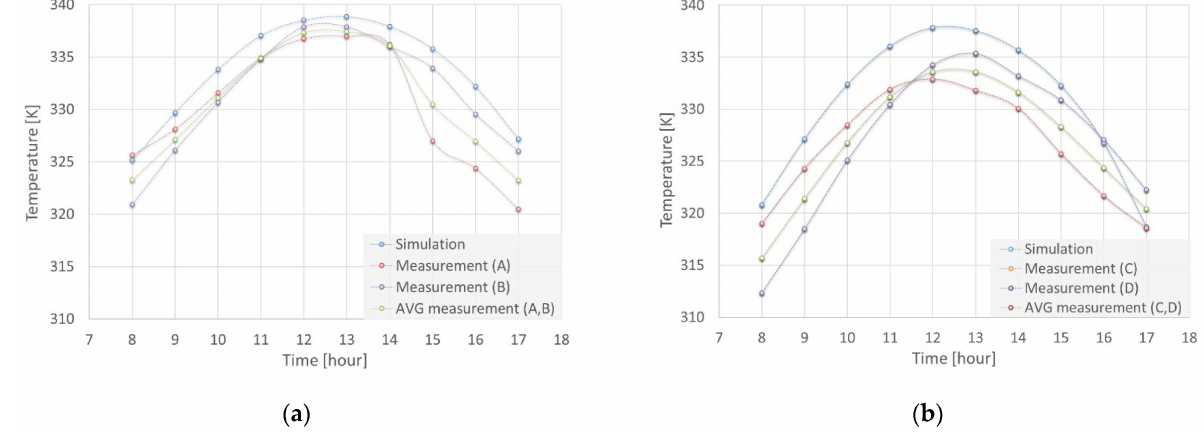
Figure 21. Comparison of the outlet temperature of solar collectors from measurement and simulation for ( a ) rotation collectors, ( b ) static collector without rotation. The relative accuracy of the model (Figure 22) for the state of rotation is 99.1%, resp.; after including 5% uncertainty, it is 94.2%. For the state without rotation it is 98.7%, resp., and after including 5% uncertainty it is 93.8%.